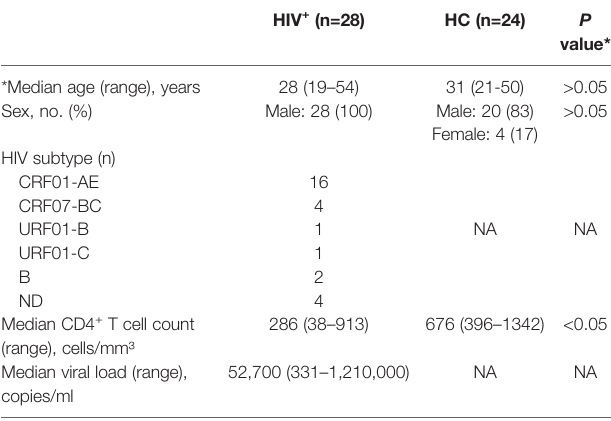
TABLE 1 | Characteristics of study